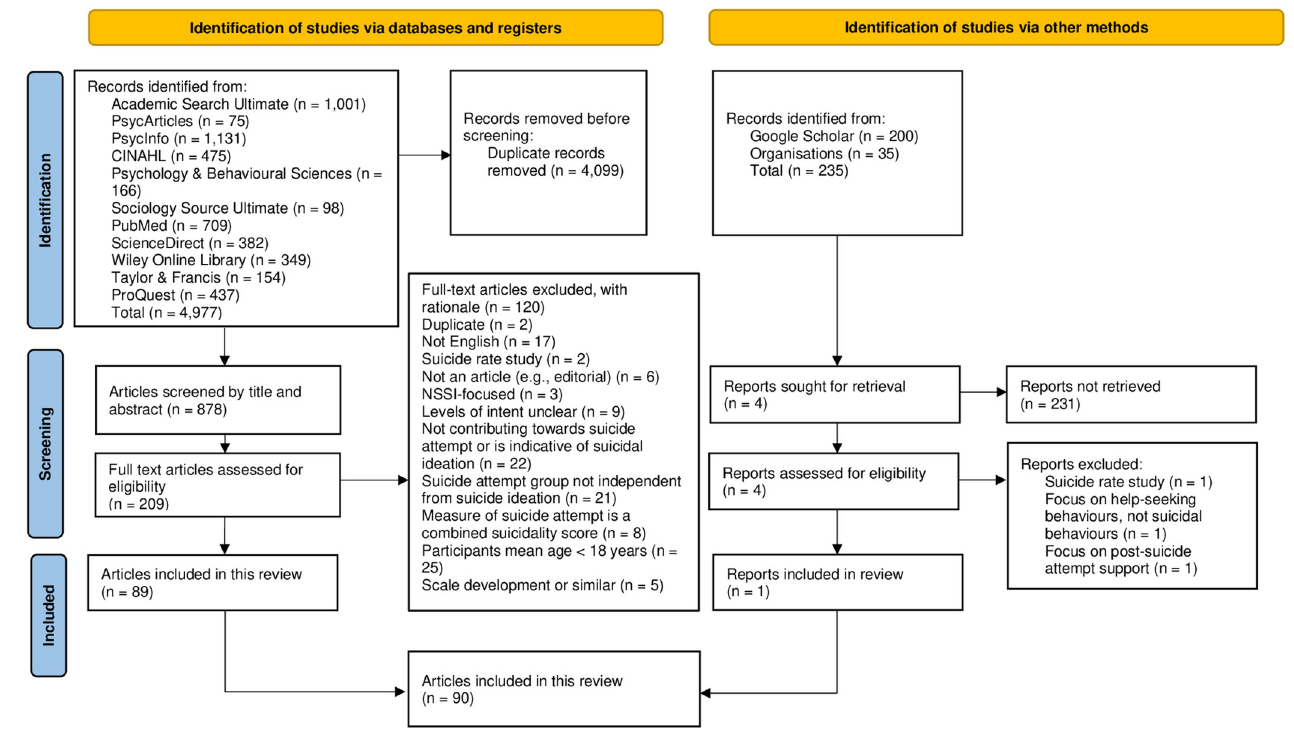
Fig 1. PRISMA flow diagram of articles election process